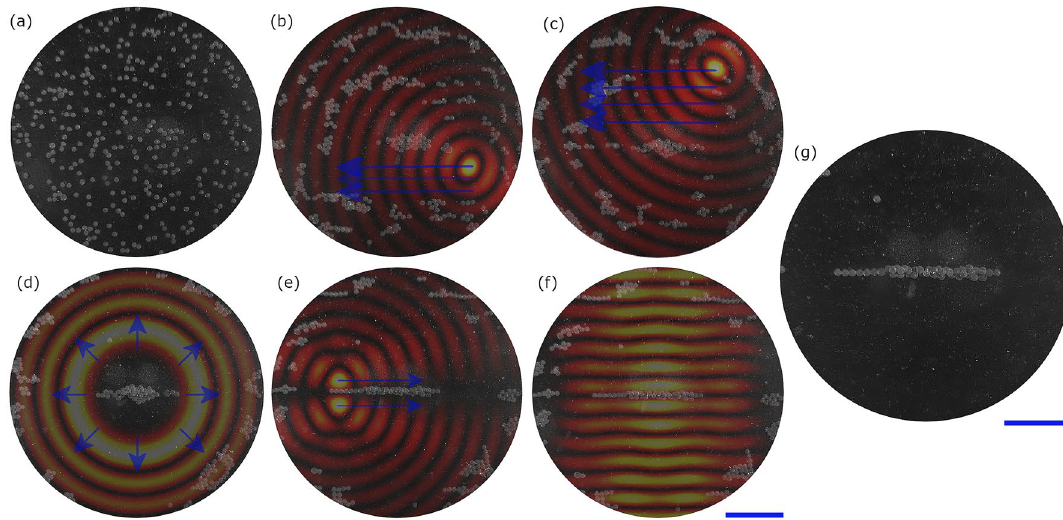
Figure 5. The process for forming a line combining clearing techniques and multiplexing. Starting with a random particle distribution in ( a ). A focused point sweep is then used “below” the line, with the results shown in ( b ). This is repeated “above” the line, clearing the area and agglomerating some particles into the line, resulting in ( c ). Increasing order Bessel functions are then cycled up resulting in ( d ). Finally the line is shaped and reinforced through a combination of switching low impulse twin traps ( e ) and applying a static standing wave ( f ), resulting in the line with a cleared area around it, as shown in ( g ). The blue scale bars are 1 mm. This process is shown in action in Supplementary Video 2.